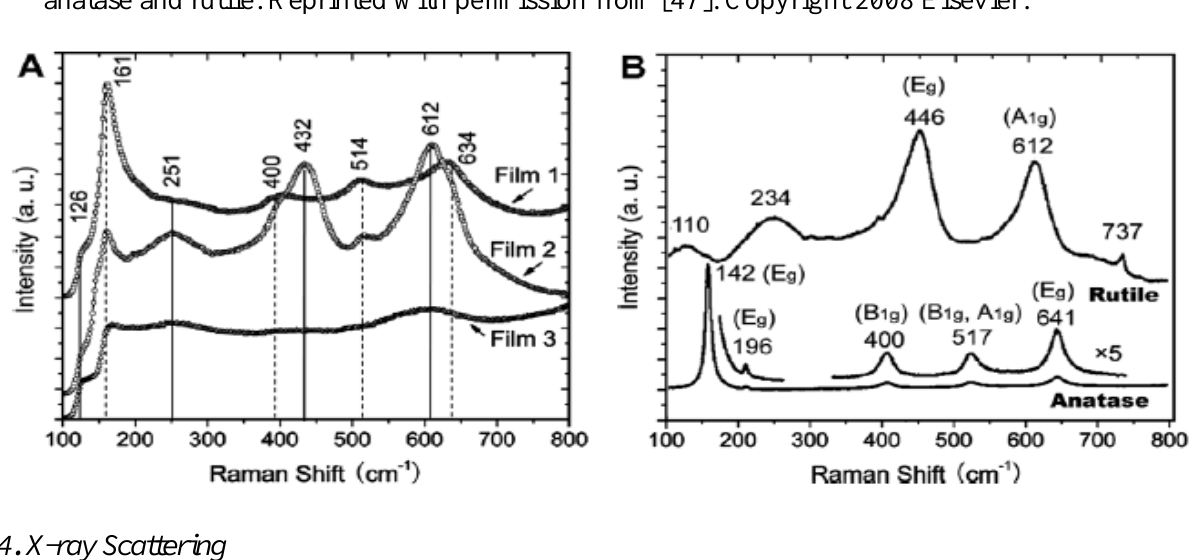
mesoporous films and ( B ) reference 2